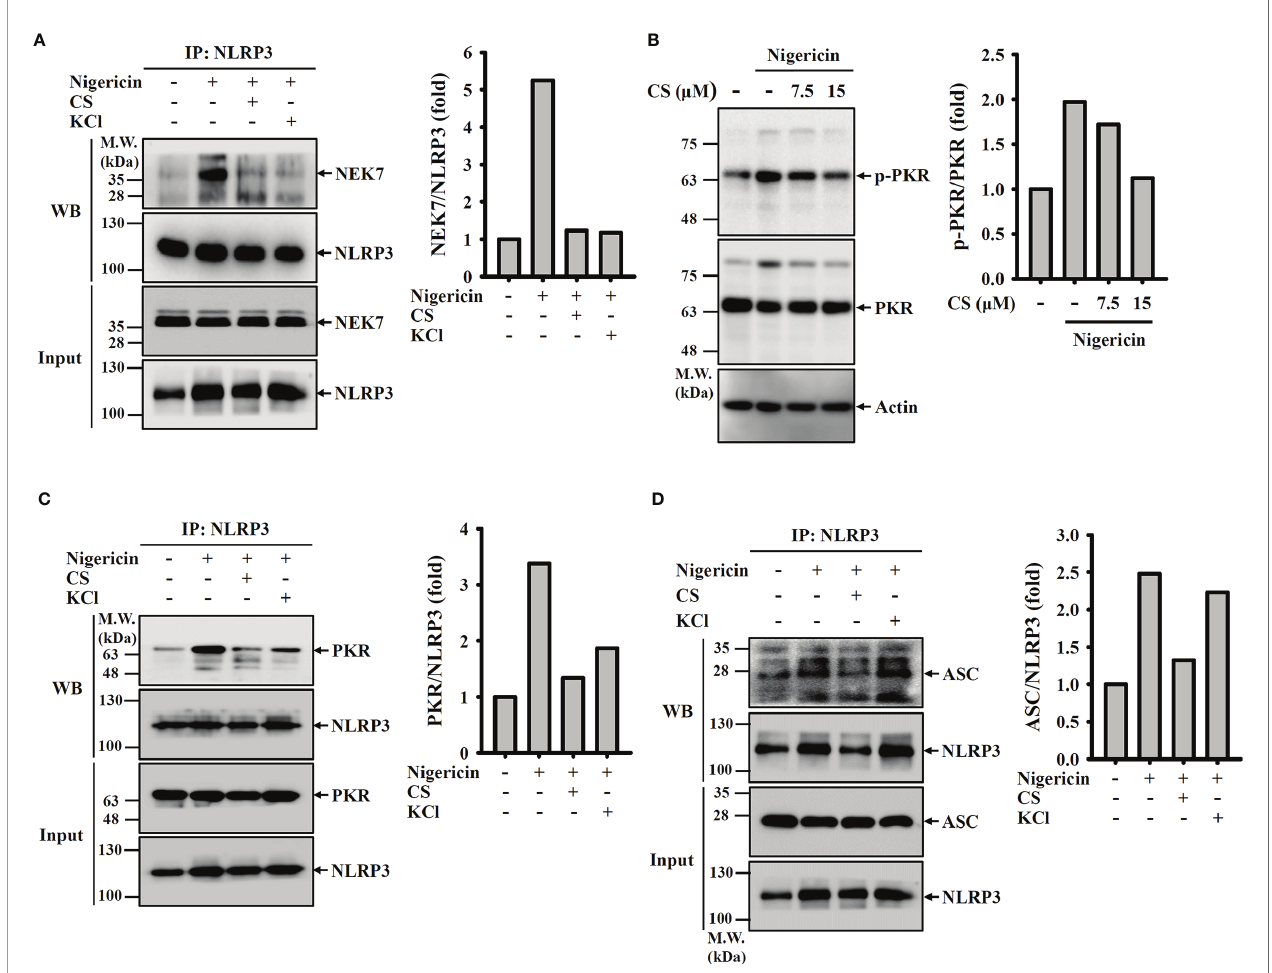
FIGURE 5 | Candesartan inhibits NLRP3 in fl ammasome assembly. (A, C, D) J774A.1 macrophages were primed with LPS for 5 h and incubated with 15 m M CS or 50 mM KCl for 0.5 h Cells were stimulated with 10 m M nigericin for 0.5 h NLRP3 was immunoprecipitated from cell lysates and Western blot against NEK7 (A) , PKR (C) and ASC (D) . (B) J774A.1 macrophages were primed with LPS for 5 h and incubated with 15 m M CS for 0.5 h. Cells were stimulated with 10 m M nigericin for 0.5 h. The phosphorylation levels of PKR in the cell lysates were measured by Western blot. The Western blot images are representative results, and the histogram shows the band